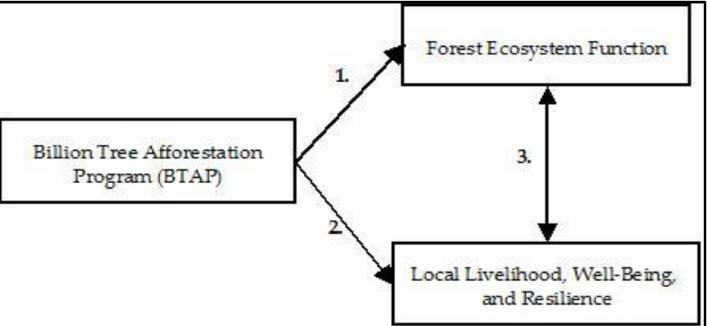
Figure 1. Billion Trees A ff orestation Program (BTAP) thinking